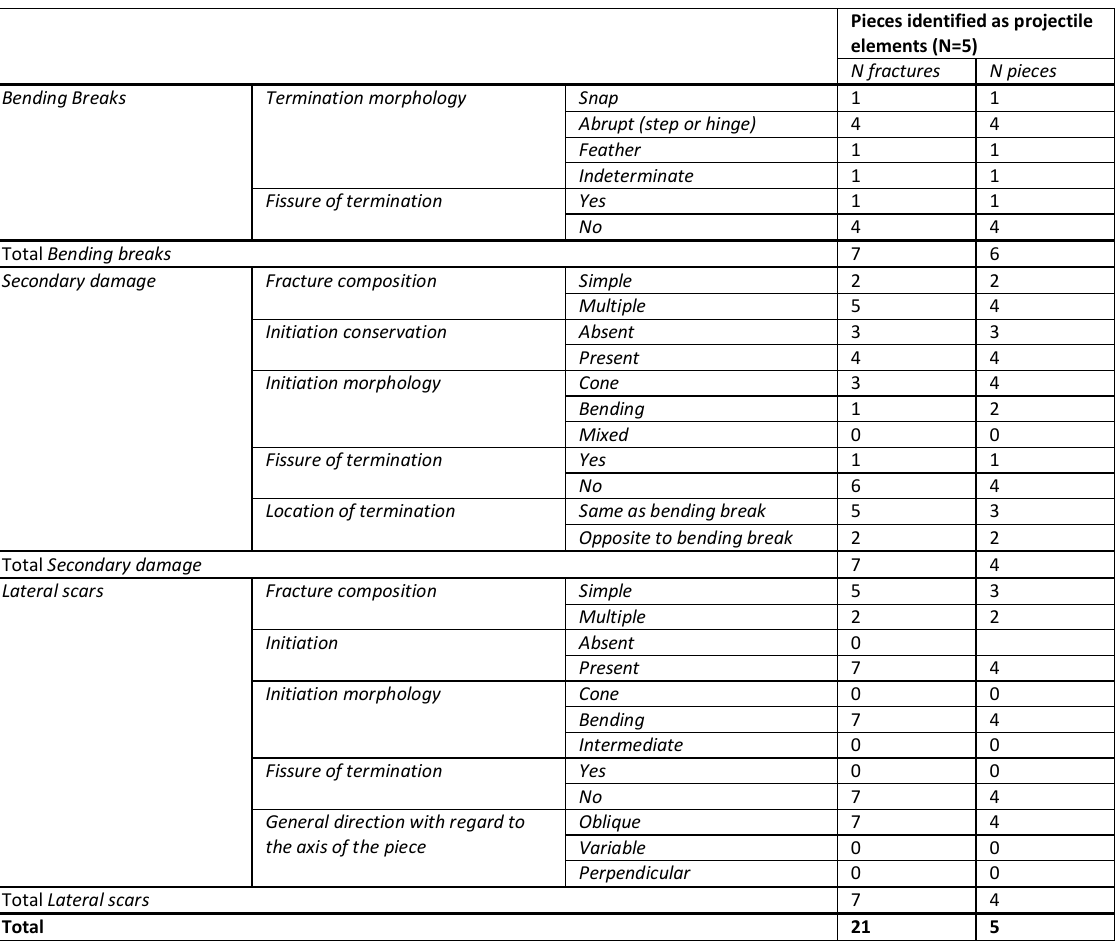
Pieces identified as projectile elements (N=5) N fractures N pieces